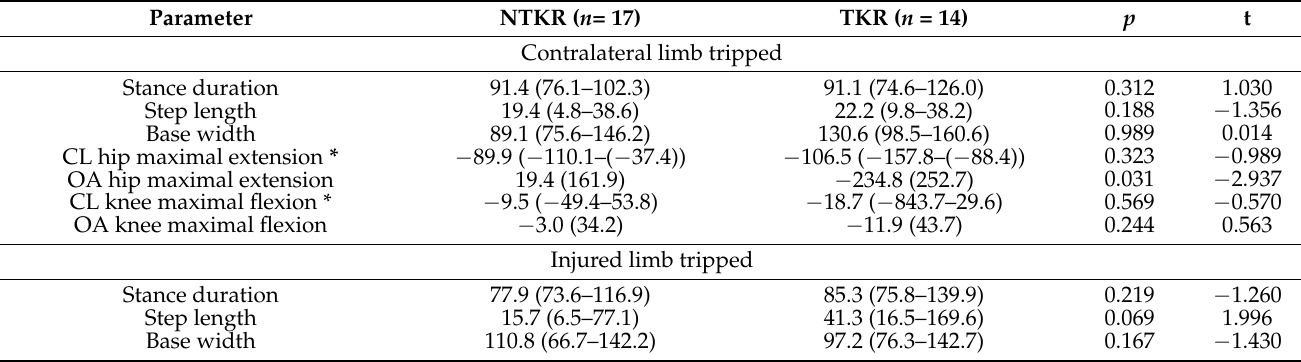
Table 3. Spatiotemporal and kinematics data of the lower limb of the perturbed gait immediately after the perturbation and the first step following the perturbation calculated by X [ % ] = average and standard